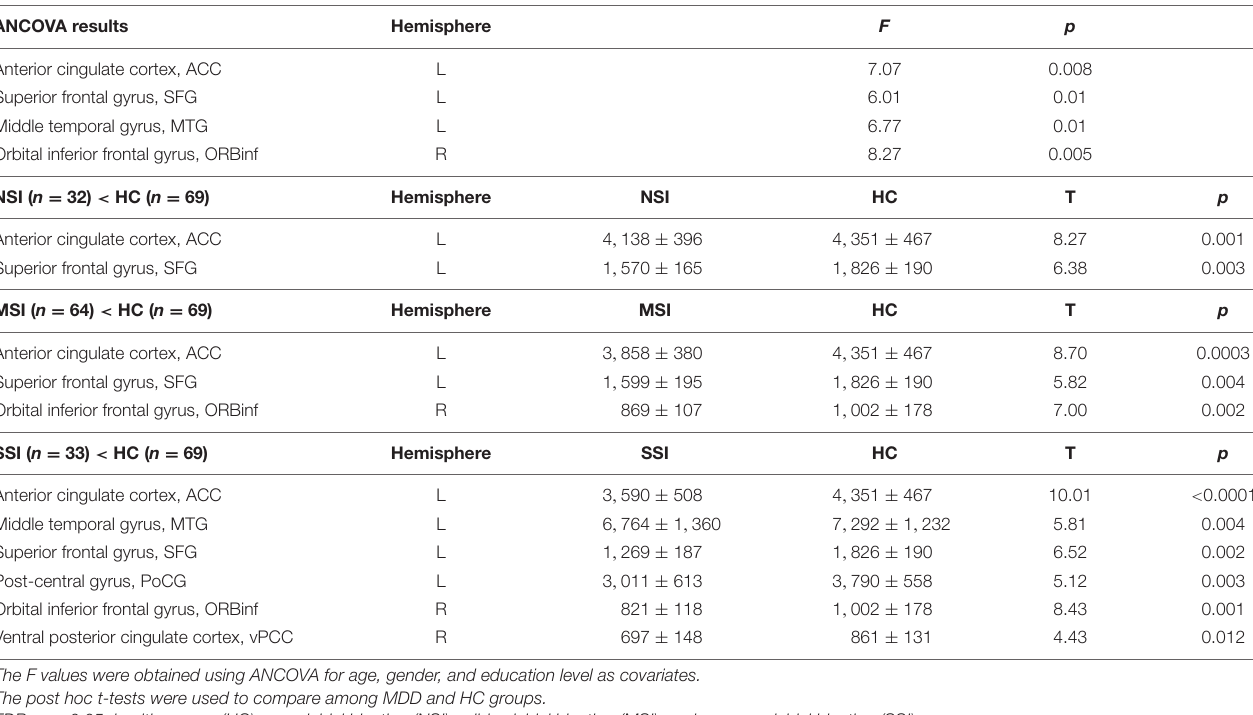
TABLE 3 | Analysis of covariance of gray matter volume among MDD and HC groups.